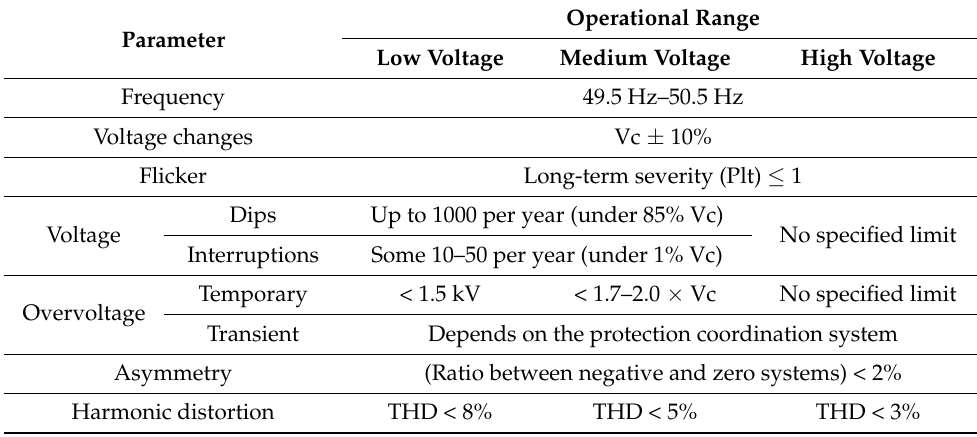
Table 4. Power quality requirements in DIN EN 50160 [26].